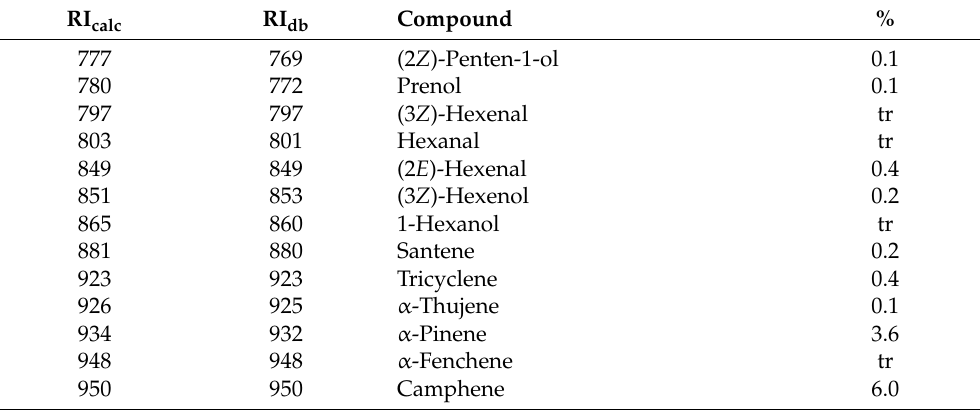
Table 2. Chemical composition (percent) of the foliar essential oil of Picea engelmannii subsp. engel- mannii from southern